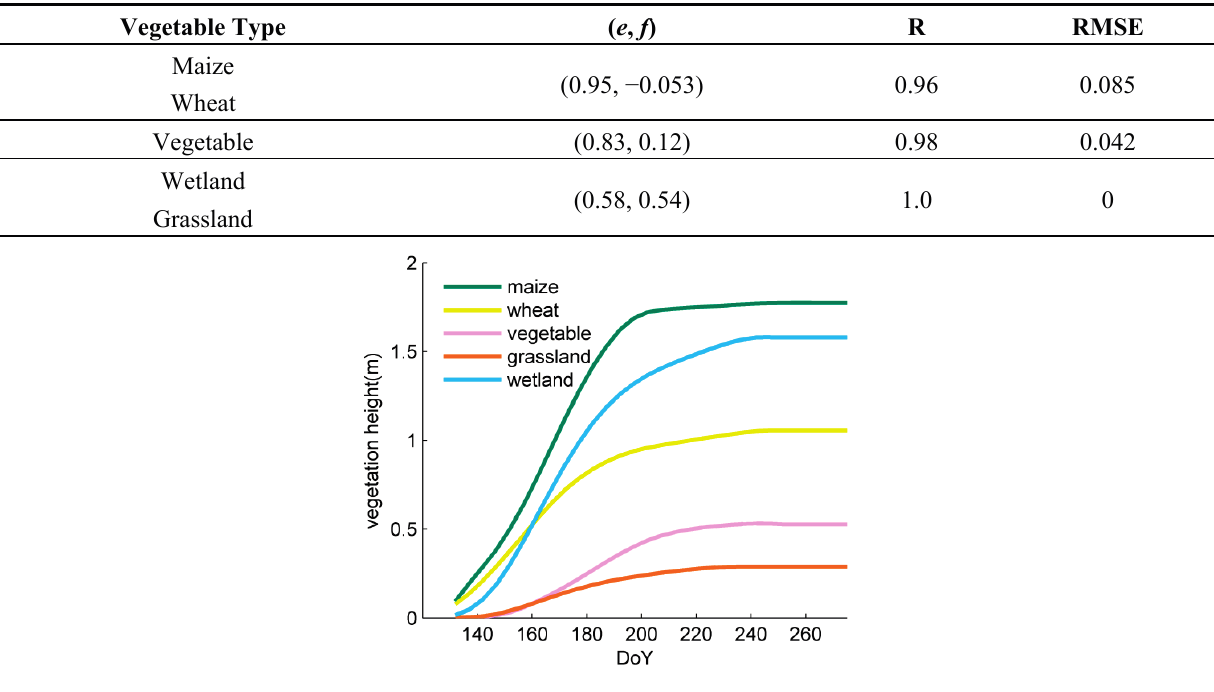
Figure 4. Time series of the area-averaged vegetation height of different herbaceous vegetation types during the growing season of 2012 in the middle reach of the Heihe River